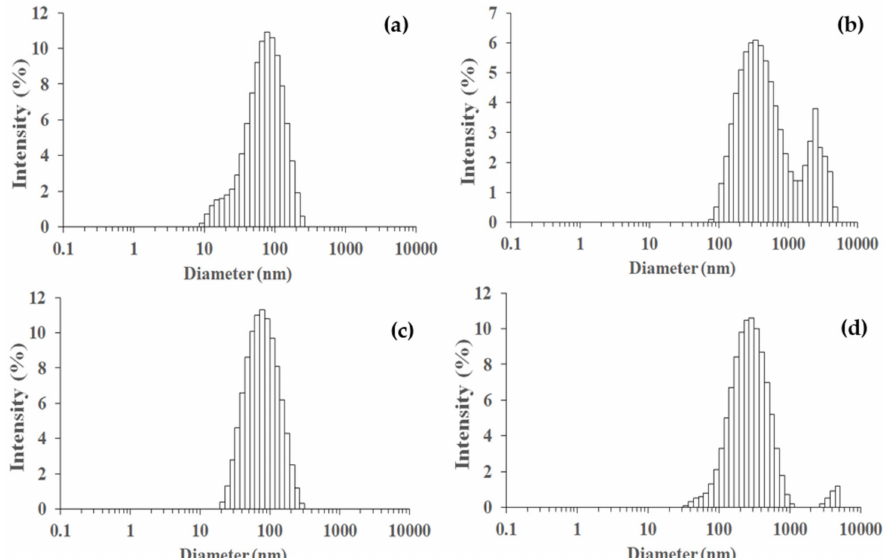
Figure 12. Particle size distributions measured on a Zetasizer Nano ZS of SiO 2 and Ti 50 Si 50 oxide synthesized at various pH values: ( a ) SiO 2 , ( b ) Ti 50 Si 50 pH 8.0, ( c ) Ti 50 Si 50 pH 9.0, ( d ) Ti 50 Si 50 pH 10.0.